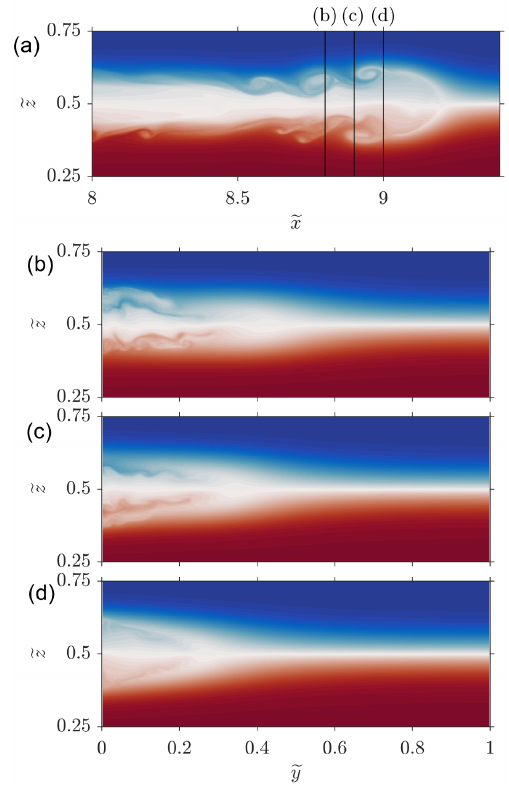
Figure 7. Horizontal kinetic energy flux density for case 10_1 at e t = 10 . 4 (t = 100s ) and e z = 0 . 5. Streamlines show the direction of the KE flux in the reference frame moving with the leading wave (i.e. flow is right to left). The colour axis shows the magnitude of the KE flux.